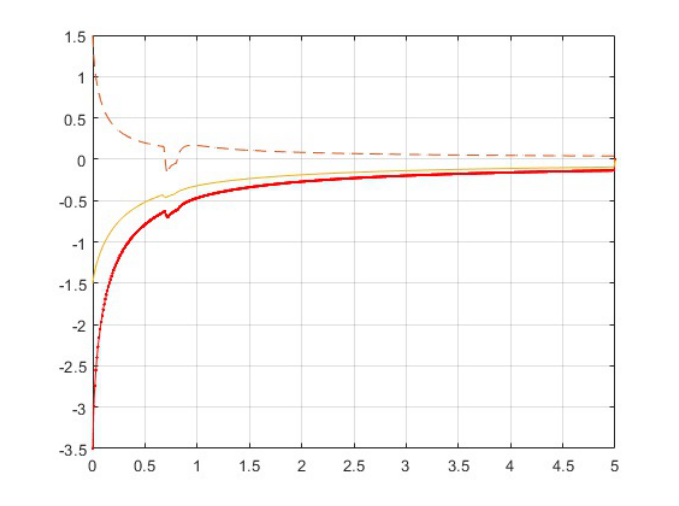
Figure 10. The leader–follower multi-agent system error states ω j ( τ )